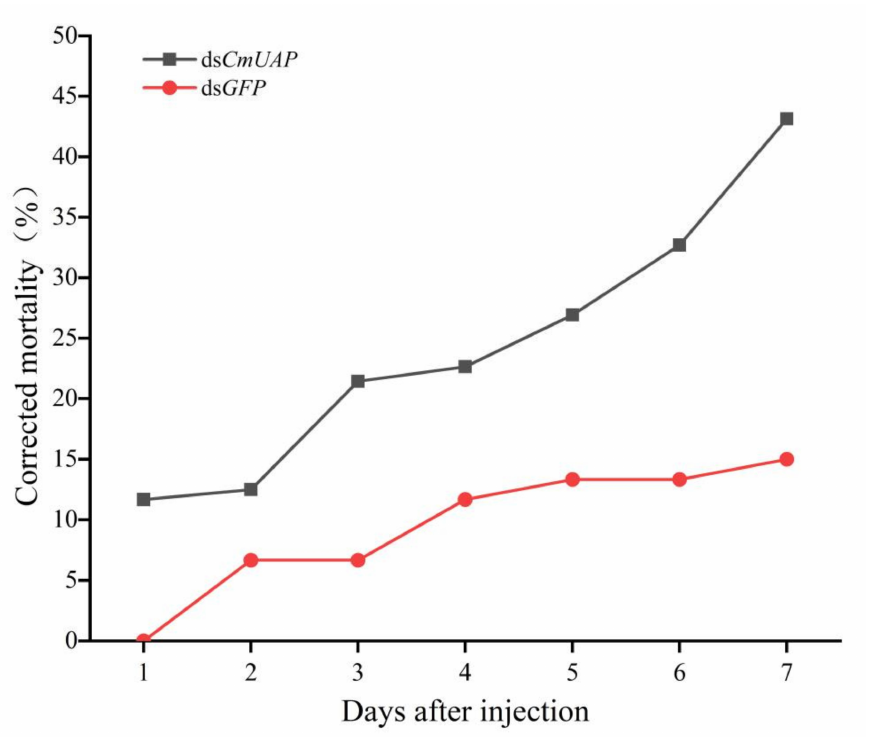
Figure 8. Corrected mortality of larvae within 7 d after dsRNA injection. Different letters above the broken lines indicate significant differences between treatments on the same day ( p < 0.05, Duncan’s test).